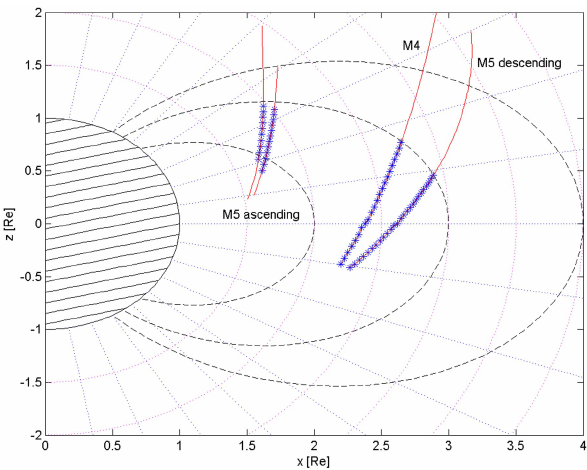
Fig. 5. Radio visible parts of the MAGION 4 and MAGION 5 satel- lite